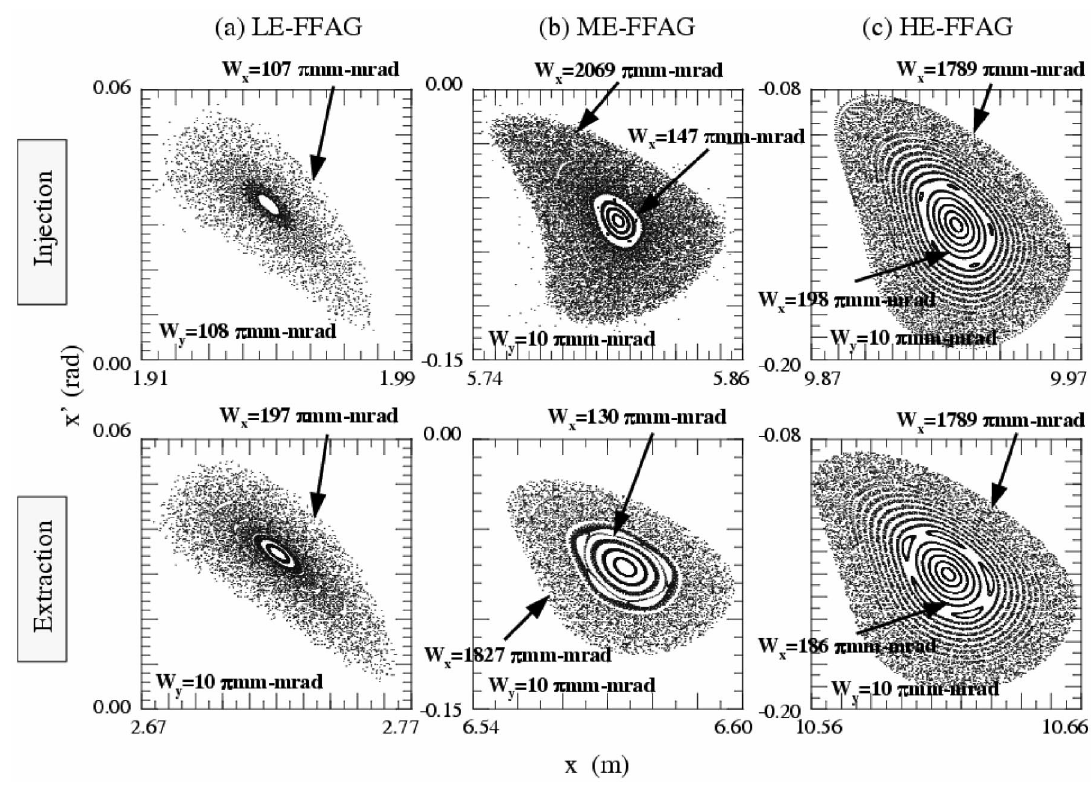
FIG. 14. Dynamic apertures for the (a) LE, (b) ME, and (c) HE rings. Top and bottom figures correspond to injection and extraction orbits, respectively. 1000 turns of tracking are